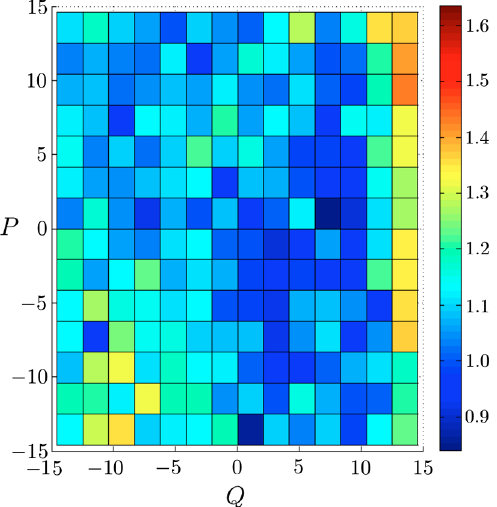
FIG. 8. The variance of the reconstructed signal data as a function of the phase-space